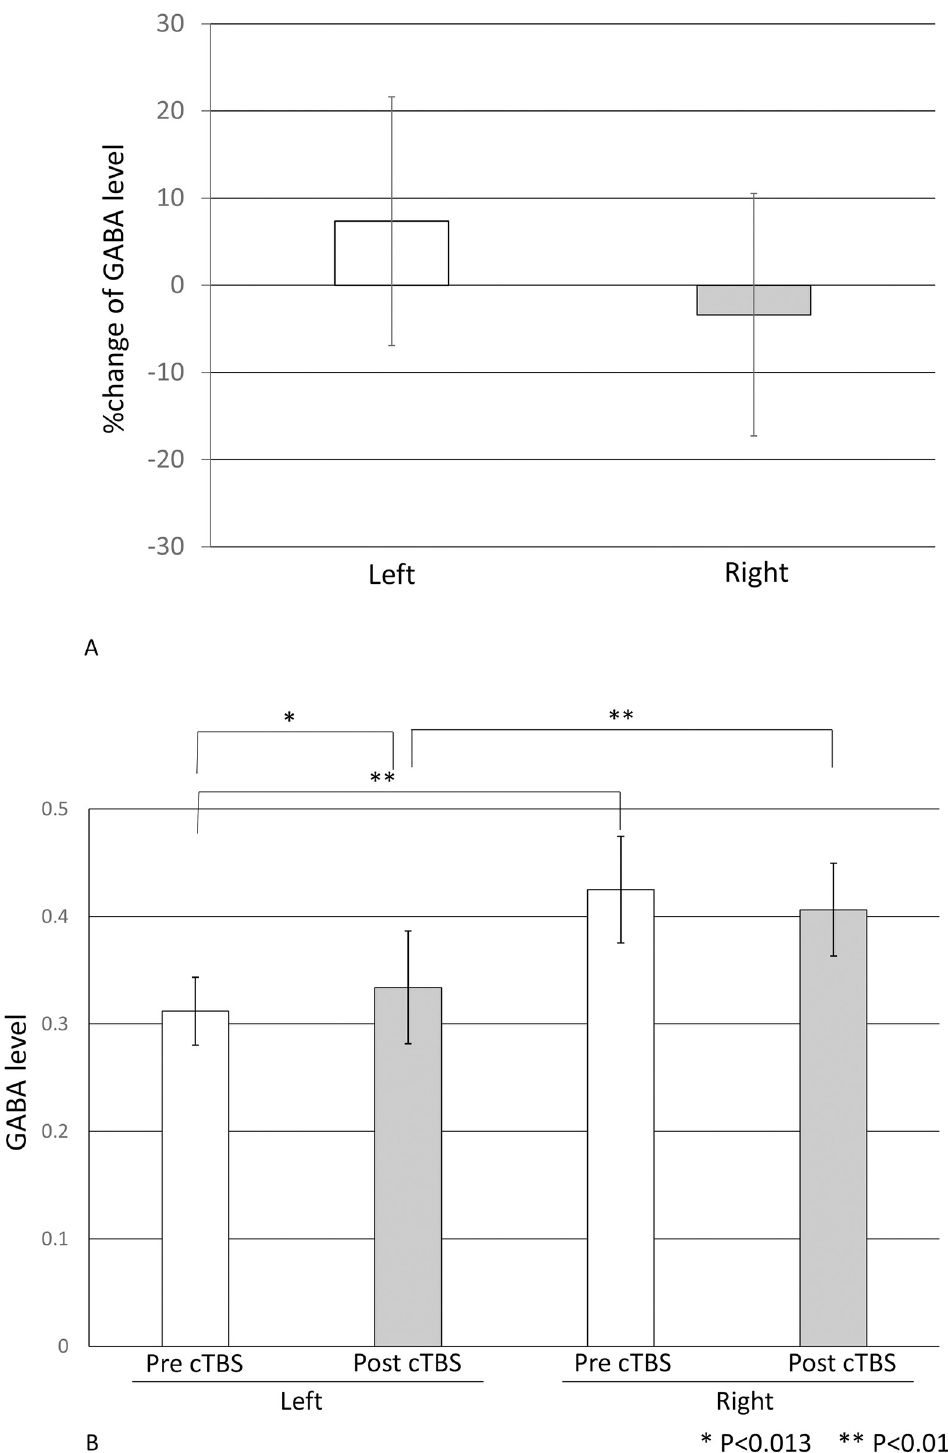
Fig 3. A) The %change in GABA level in the left and right M1. GABA level increased by 7.35% ± 14.26% in the left M1 and decreased by 3.38% ± 13.9% in the right M1 following cTBS. B) GABA levels before and after cTBS. GABA levels were significantly lower in the left hemisphere (dominant side) than on the right hemisphere (nondominant side) before and after stimulation but were significantly increased in the left hemisphere after stimulation.